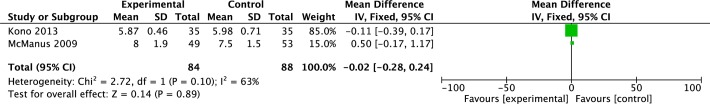
Forest Plot: HbA1c.